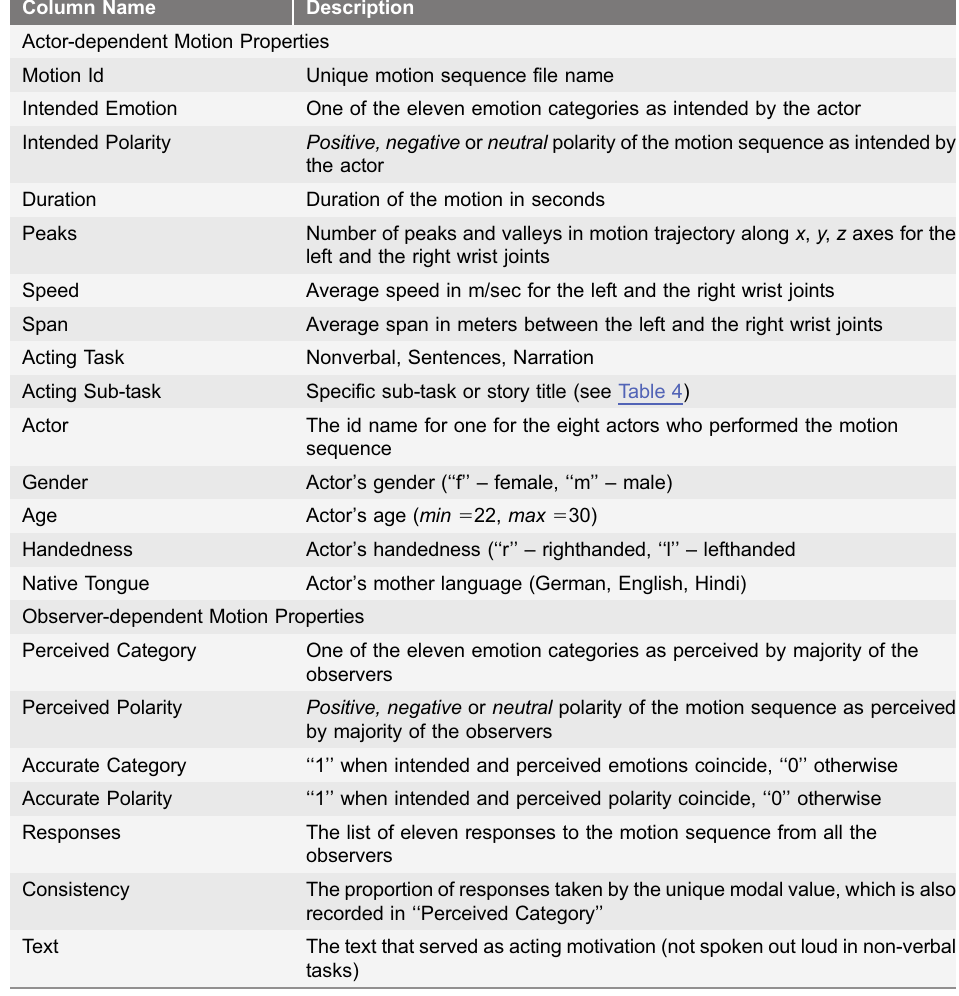
Table 8. Online Database